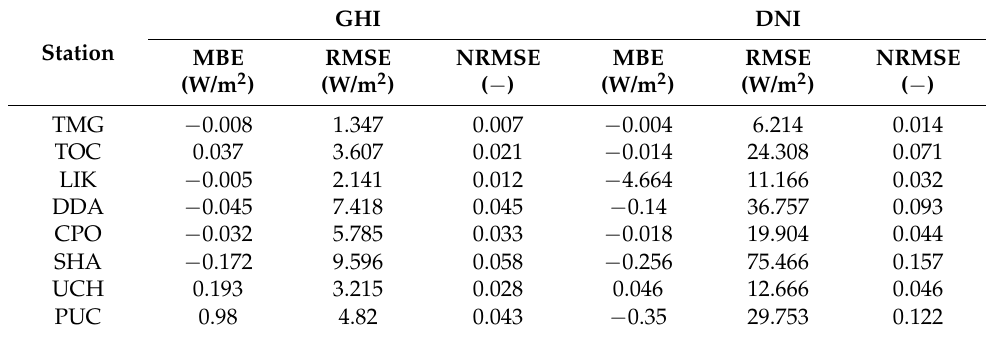
Table 4. Estimation errors for irradiance under no eclipse conditions for the measurement stations.